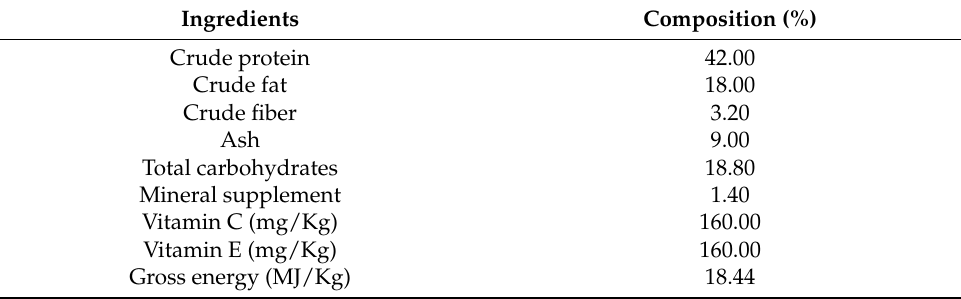
Table 1. Nutritional composition of commercial feed 1